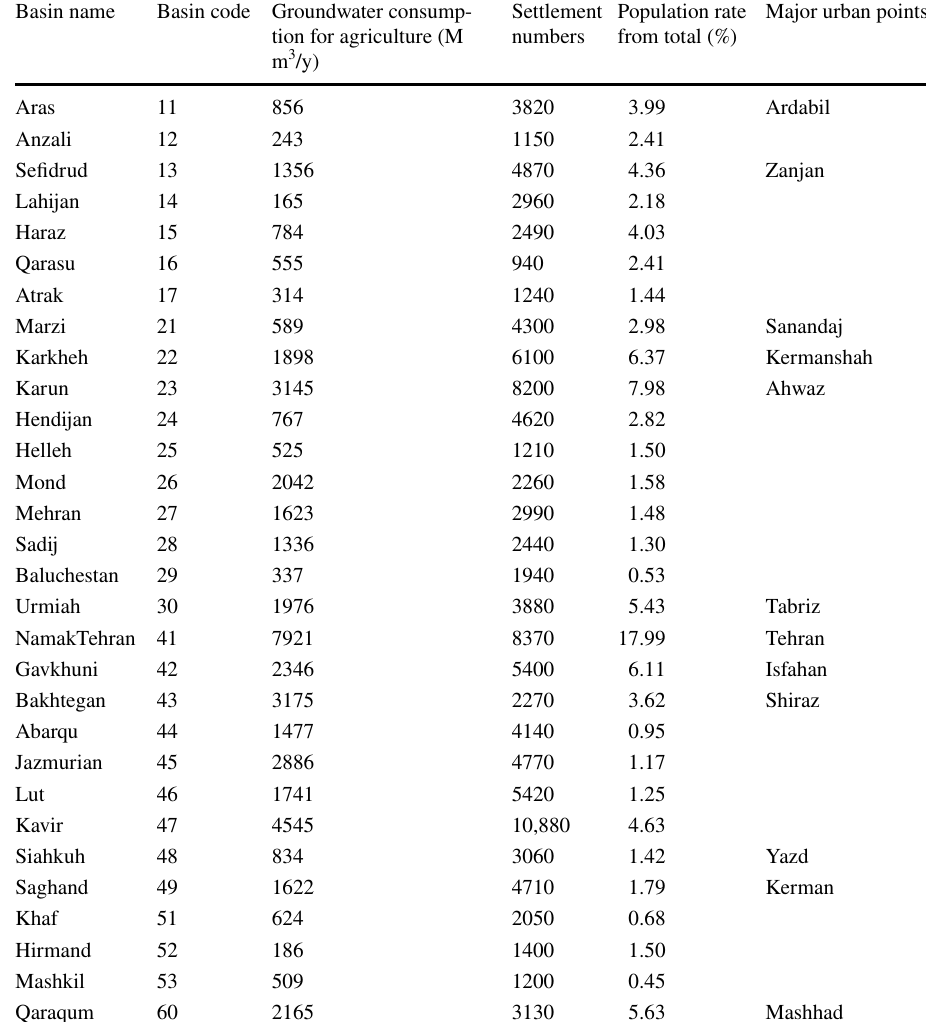
Table 8 Inventory of environmental variables of 30 major hydrological basins in Iran, including annual groundwater consumption for agriculture uses, settlement numbers, population rates, and main